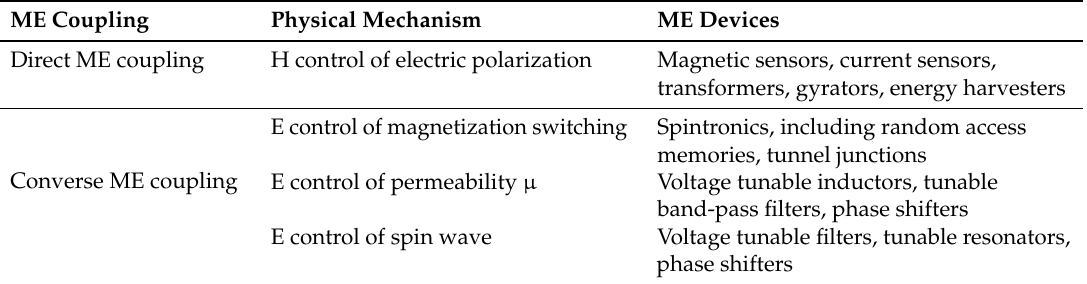
Table 2. Classification of different ME devices. Adapted from